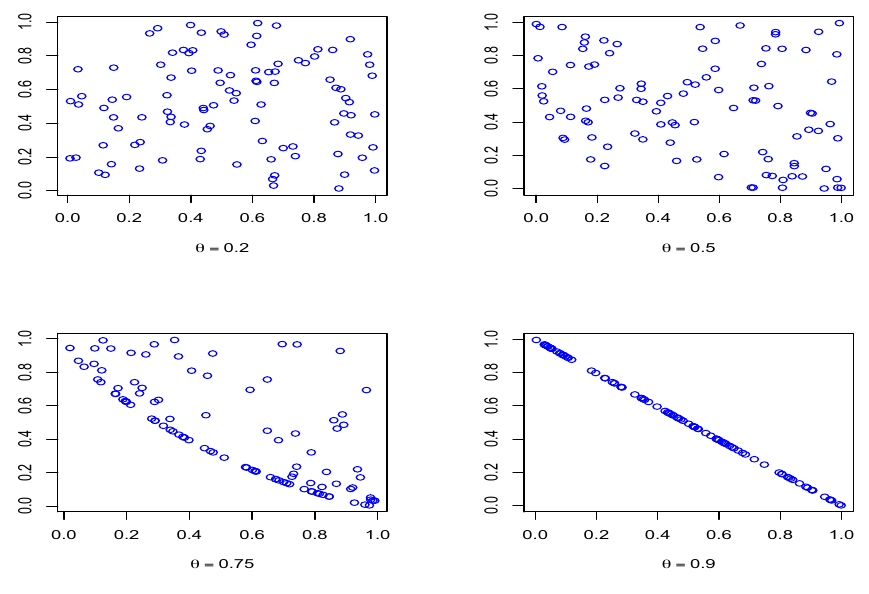
Figure 2. Scatterplots for C θ . Proposed copula C θ ( u , v ) based on different values of θ is displayed in Figure 3.